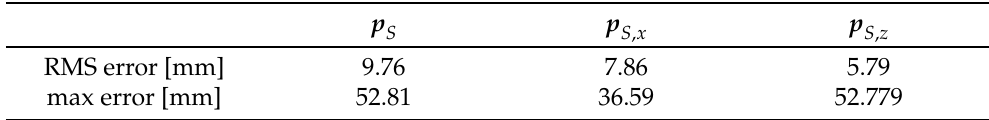
Figure 14. Comparison between the x component of the spray frame position determined by the encoder measurements, and that determined externally via the Optitrack camera system, denoted p S , x and p O , respectively. The bottom plot shows the corresponding error p err S , x Table 3. Spray frame position errors measured with the Optitrack camera system, during the indoor